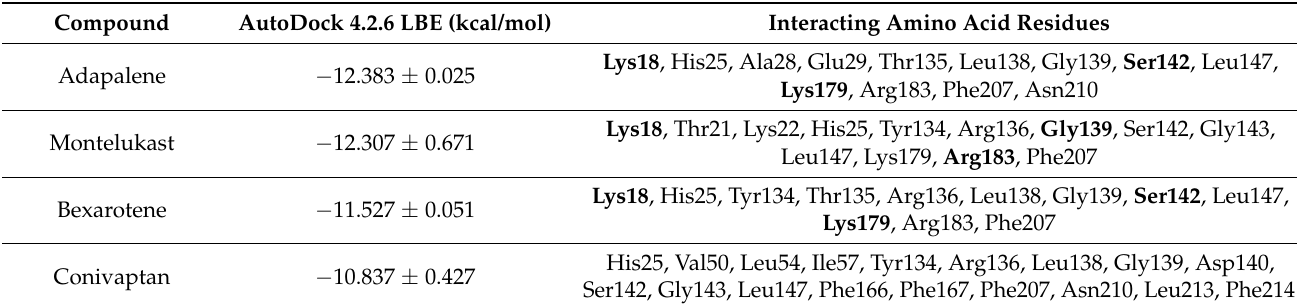
Figure 3. Effect of HMOX1, NEIL2, and PRKCA overexpression on doxorubicin and daunorubicin resistance. Dose response curves for ( A ) doxorubicin and ( B ) daunorubicinIC 50 values for ( C ) doxorubicin and ( D ) daunorubicin treatment. Table 1. In silico screening of FDA-approved drugs binding to HMOX1. Shown are the top 10 out of 1577 tested drugs. The amino acid residues in bold formed hydrogen